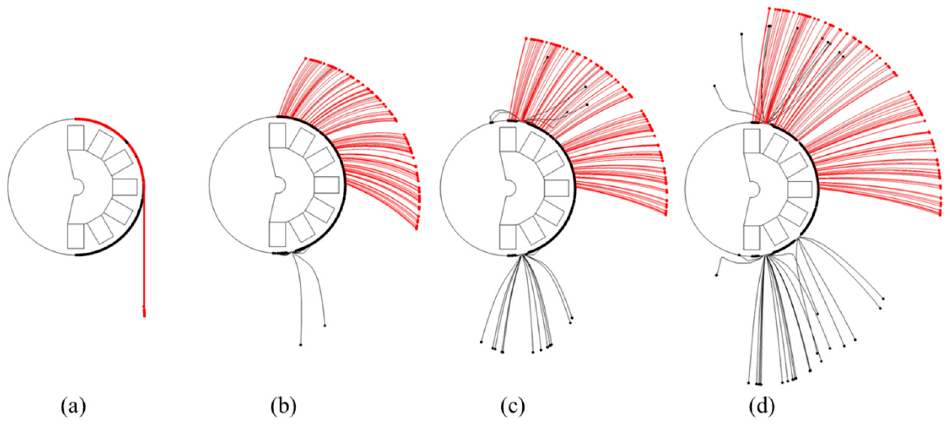
Figure 11. Particle trajectory under different airflow velocity: ( a ) V 0 = 0 m/s, ( b ) V 0 = 1 m/s, ( c ) V 0 = 2 m/s, and ( d ) V 0 = 3